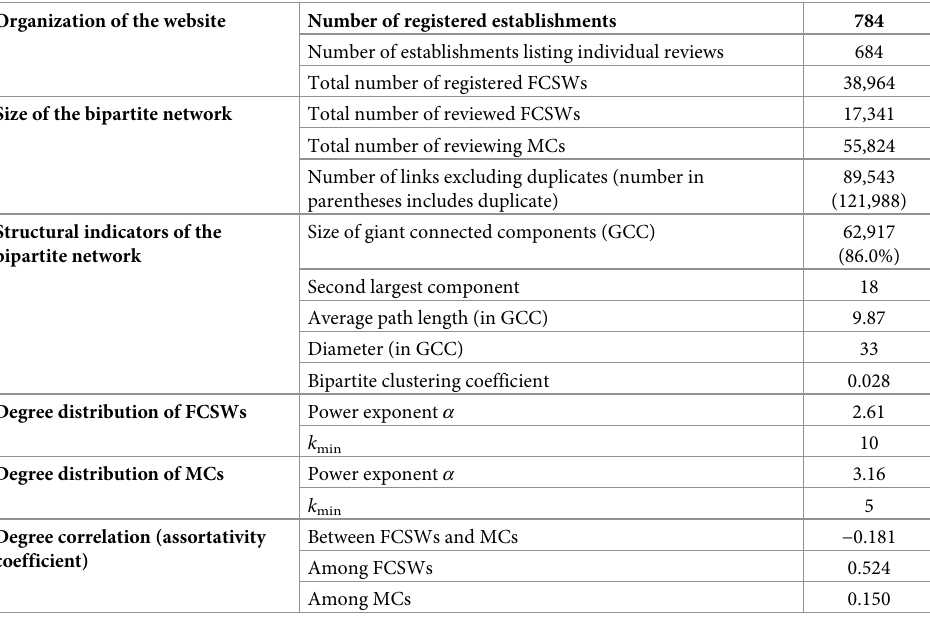
Table 1. Characteristics of a sexual contact network extracted by reviewing a sex industry